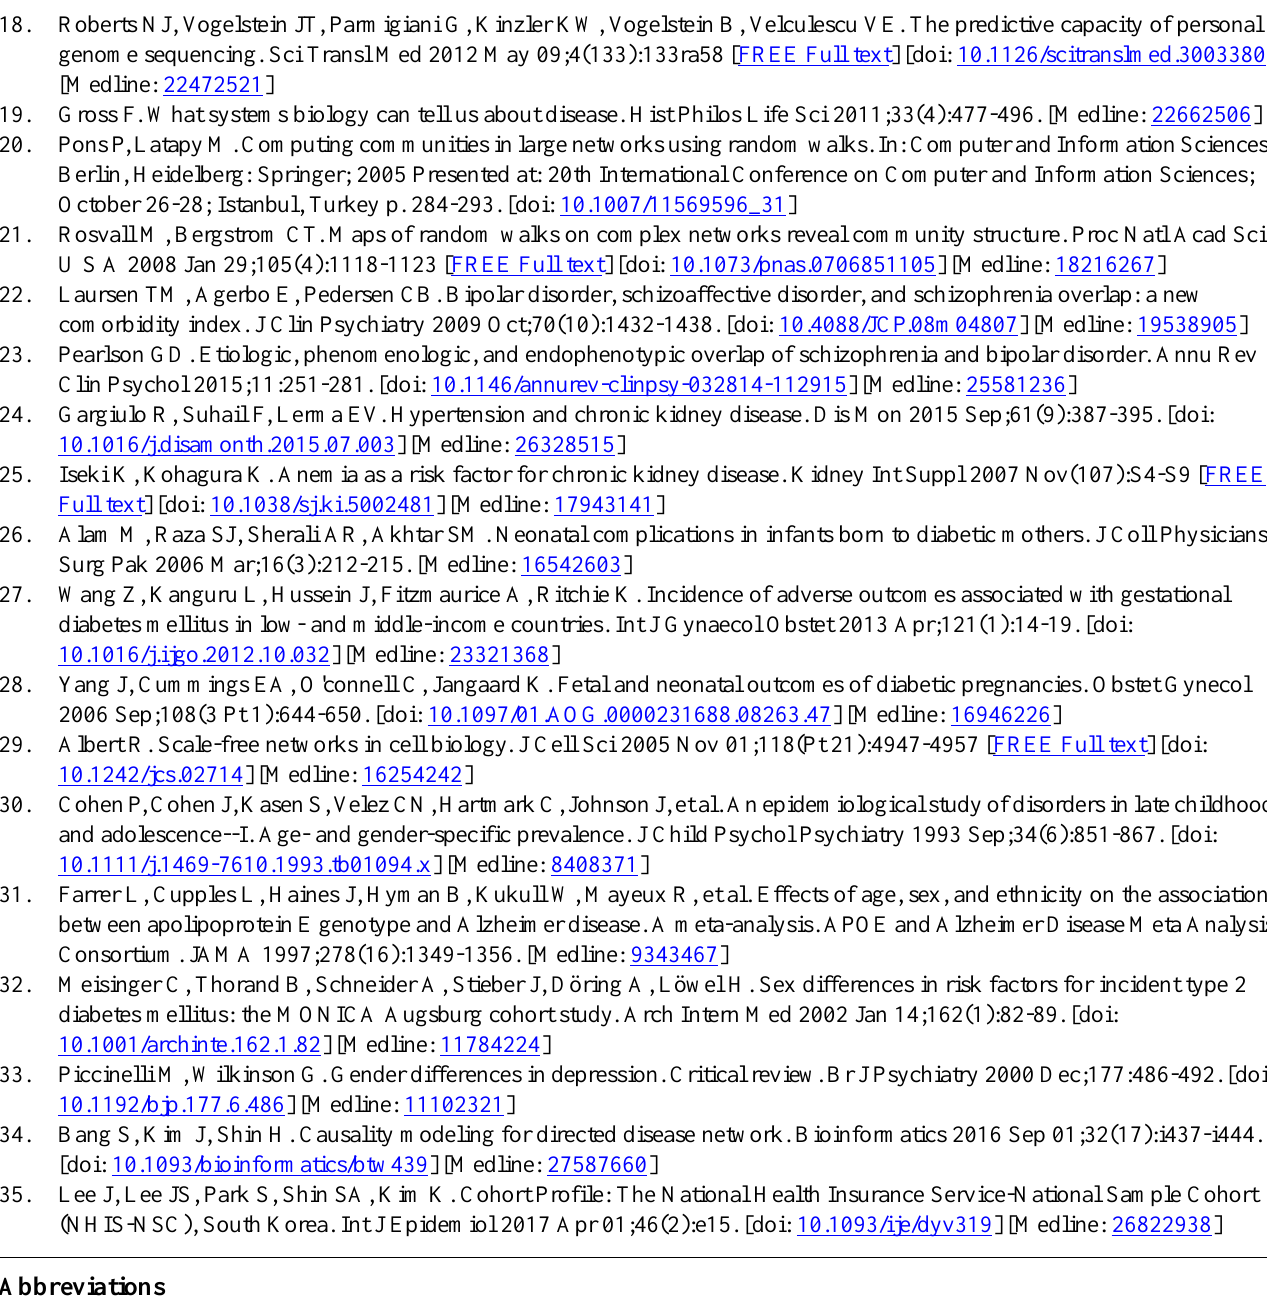
FDR: false-discovery rate ICD-10: International Statistical Classification of Diseases, 10th version KCD-6: Korean Classification of Diseases, sixth revision NHIS-NSC: National Health Insurance Service-National Sample Cohort RR: relative